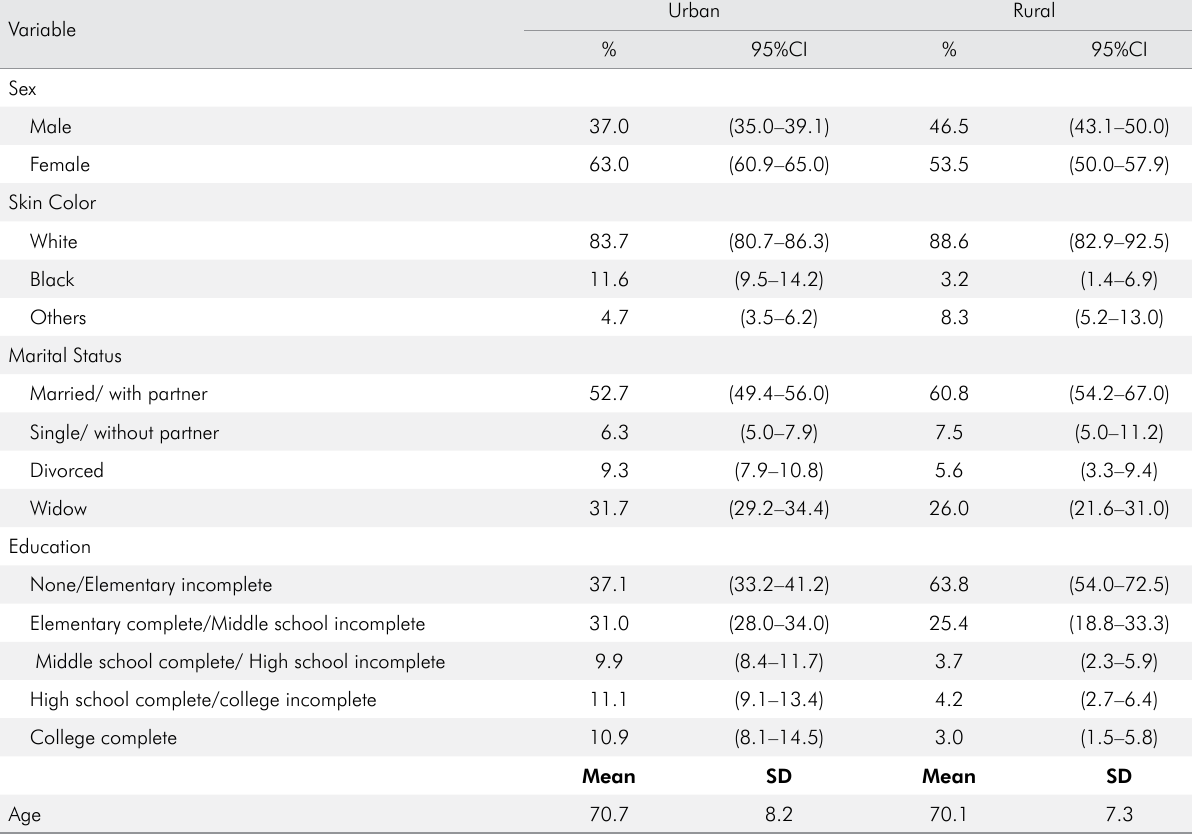
Table 1. Sociodemographic, socioeconomic and general health characteristics of the sample.